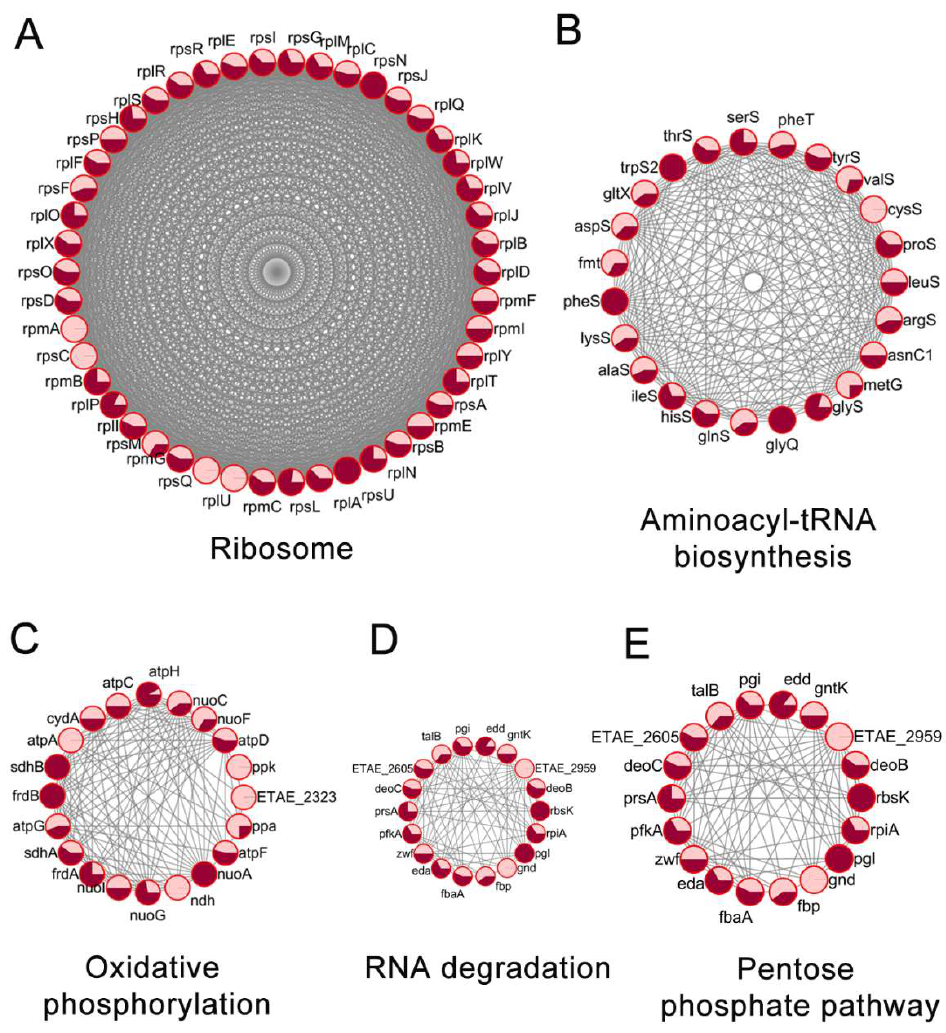
Figure 5. Prediction of protein-protein interaction networks of lysine acetylation and succinylation proteins in E. tarda . There were five highly metabolic pathways of PTM proteins were enriched in global PPI network, such as, ( A ) ribosome, ( B ) aminoacyl-tRNA biosynthesis, ( C ) oxidative phosphorylation, ( D ) RNA degradation, ( E ) pentose phosphate pathway. Different colors display different modifications; the pink and red cycles represent the proportions of Kac and Ksu modifications in single proteins, respectively.